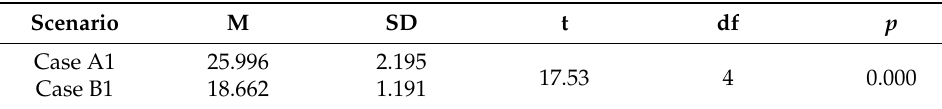
Table 13. Results of the paired sample t -test for scenario 1.